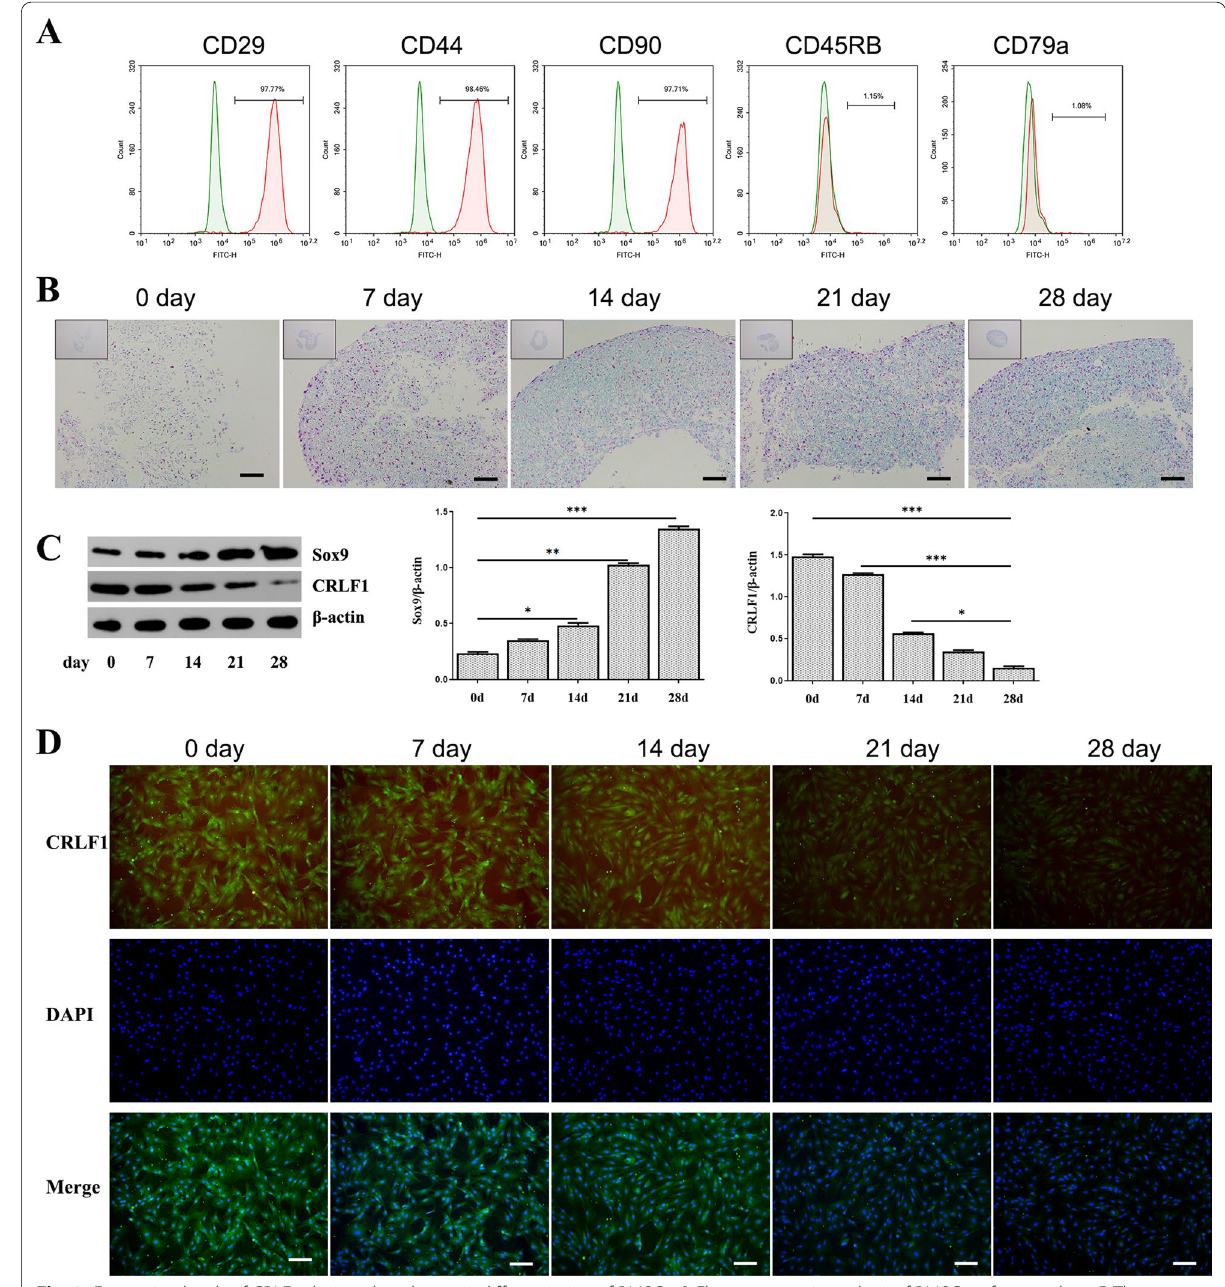
Fig. 2 Expression levels of CRLF1 during chondrogenic differentiation of BMSCs. A Flow cytometric analysis of BMSC surface markers. B The deposition of cartilage matrix proteoglycans was determined by Alcian blue staining, nuclei were counterstained by nuclear fast red (scale bar, 100 μm). C Expression of Sox9 and CRLF1 was examined by WB. D Immunofluorescence staining for CRLF1 (green), nuclear stain DAPI (blue), and Merge for green and blue (scale bar, 100 μm); Data are expressed as